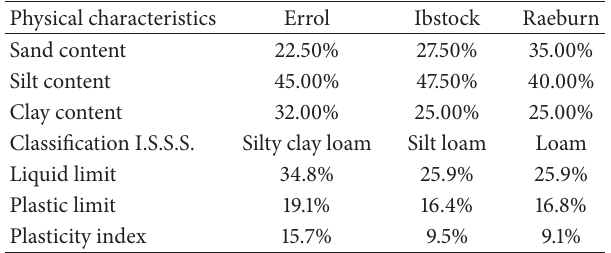
Table 1: Physical characteristics, grain size, and Atterberg limits of the three soils.